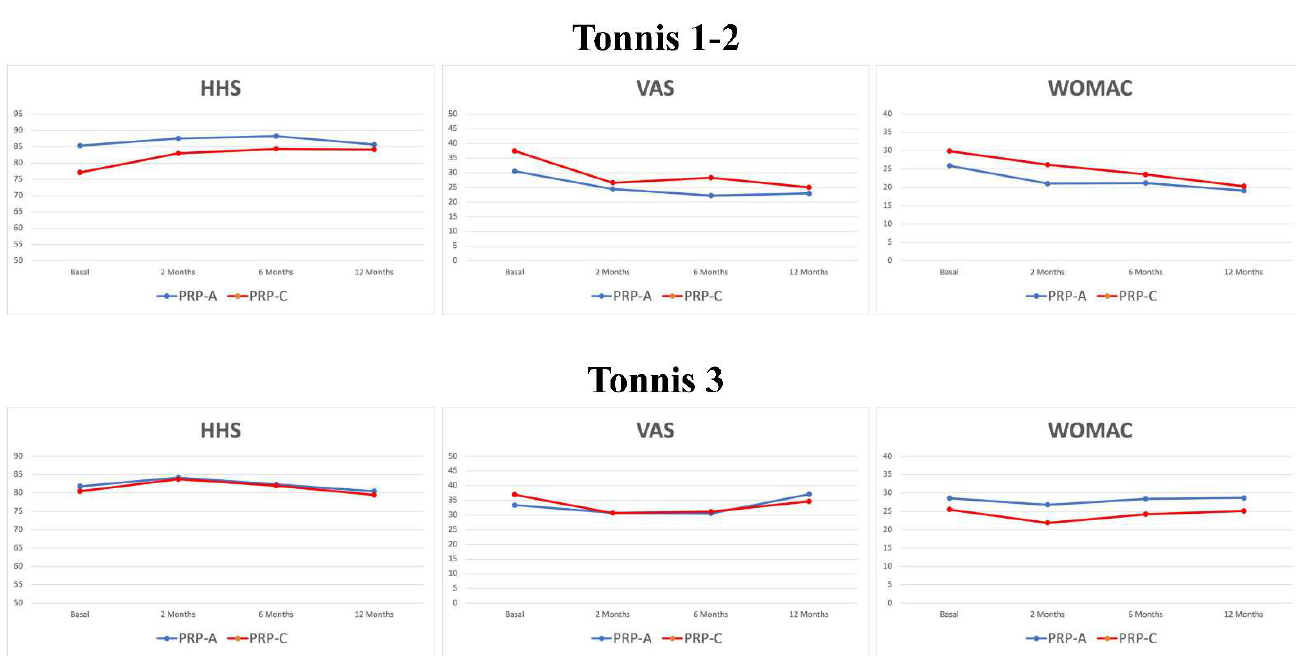
Figure 5. Trends of the evaluated clinical scores based on the OA severity.